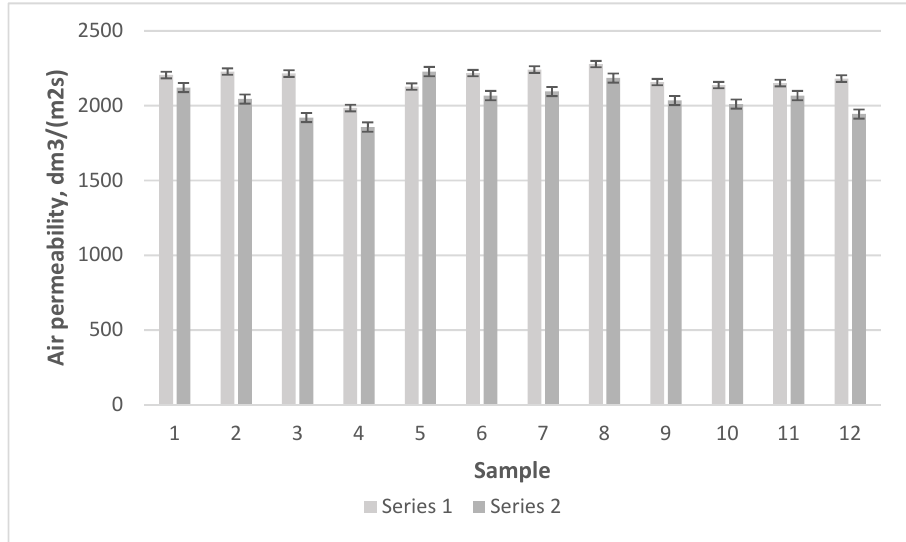
Figure 12. Air permeability of Series 1 and 2 fabrics.